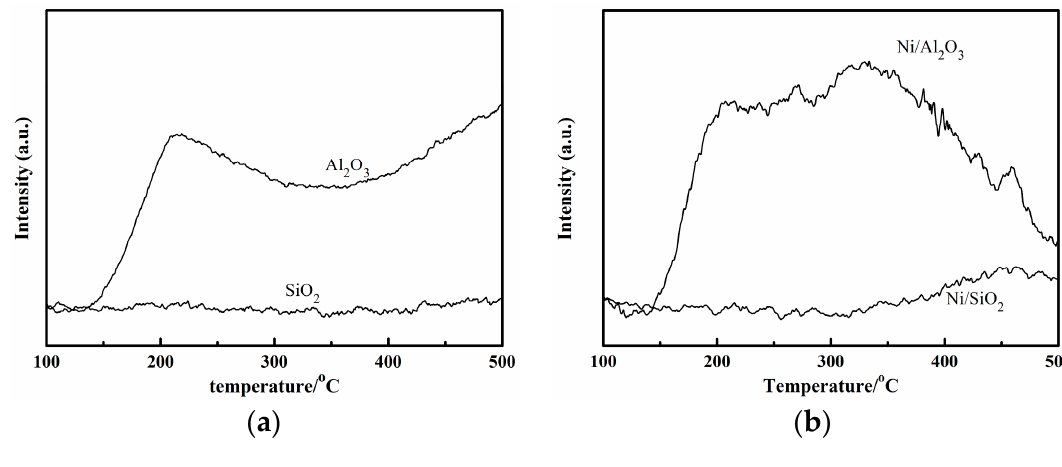
Figure 2. NH 3 -TPD of ( a ) Supports and ( b ) Catalysts.